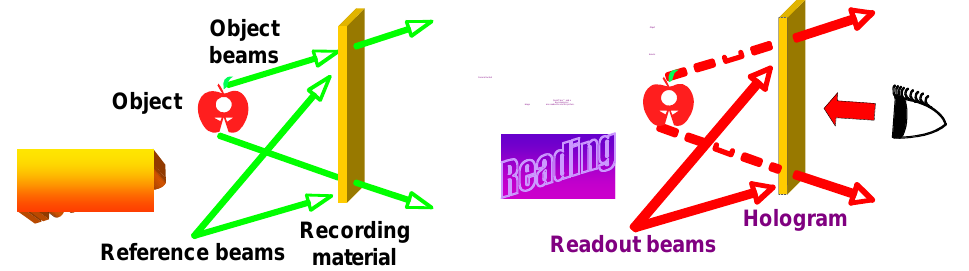
Figure 20. Schematic illustrations of recording and reading processes in volume storage based on PRBC